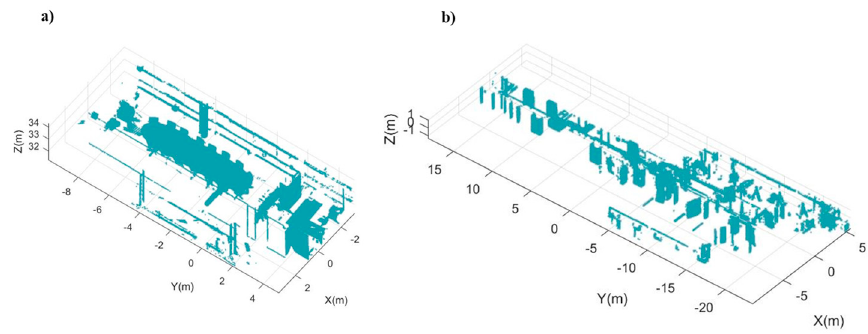
Figure 8. Obstacle class obtained after segmentation for case study 3 ( a ) and case study 4 ( b ).